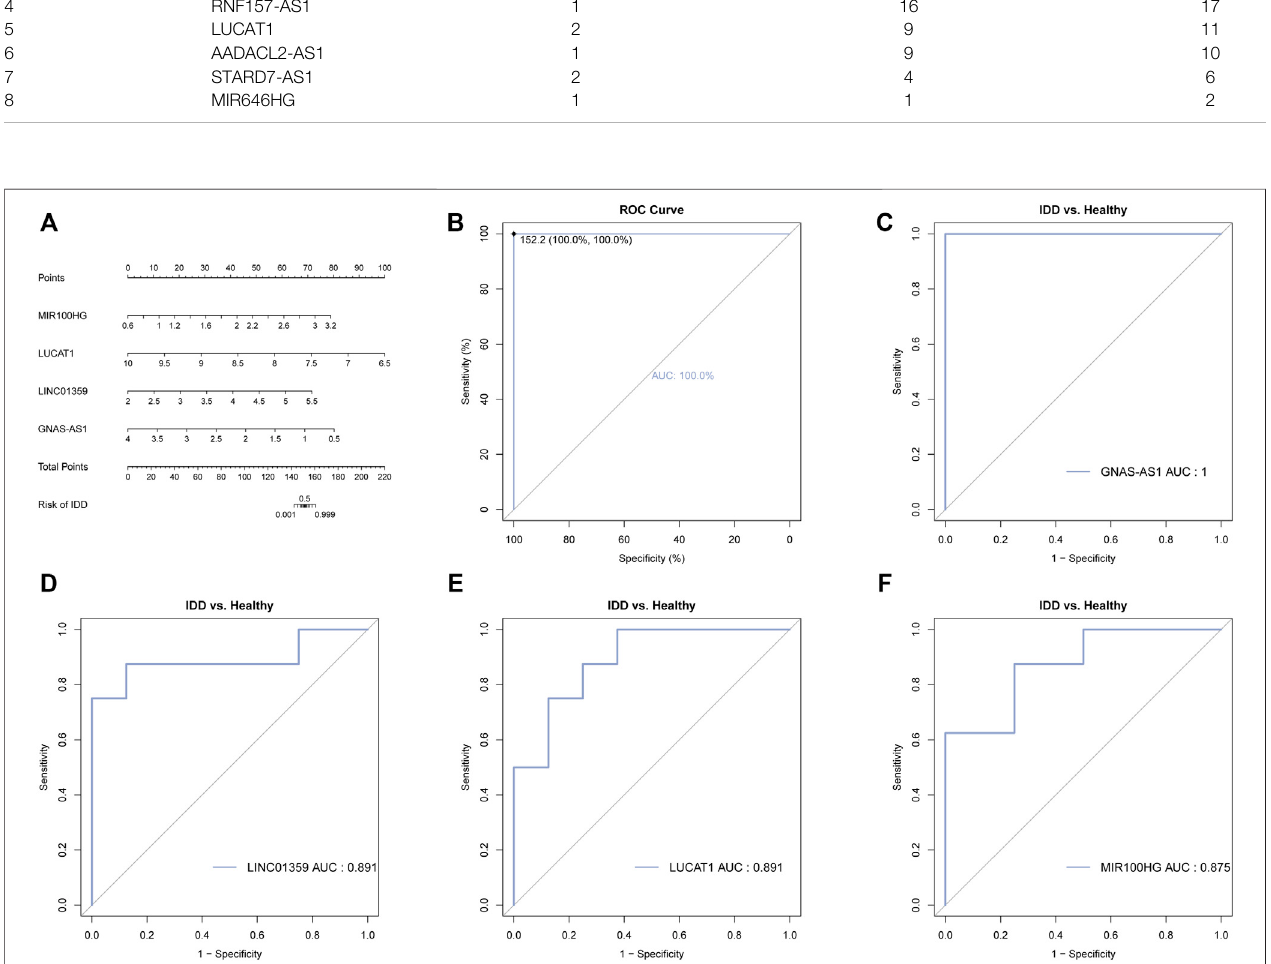
FIGURE 6 | Diagnostic and prognostic value of the four key lncRNAs. (A) Nomogram of the four key lncRNAs. The value of each lncRNA was given a score on the point scale axis. A total score could be easily calculated by adding every single score and, by projecting the total score to the lower total point scale, we were able to estimate the probability of IDD. (B) The calibration curve for the nomogram. (C) ROC analysis of GNAS-AS1. (D) ROC analysis of LINC01359. (E) ROC analysis of LUCAT1. (F) ROC analysis of MIR100HG.